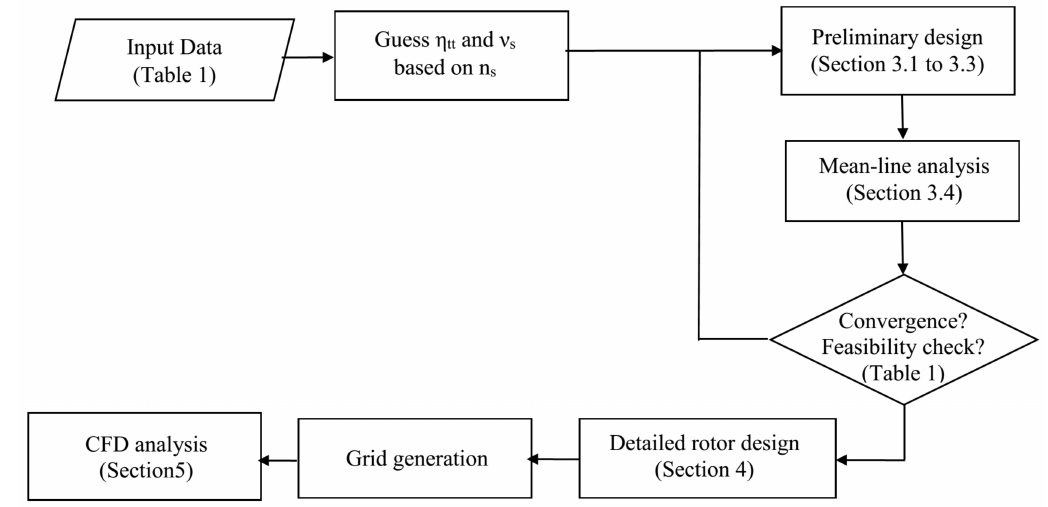
Figure 1. Design process